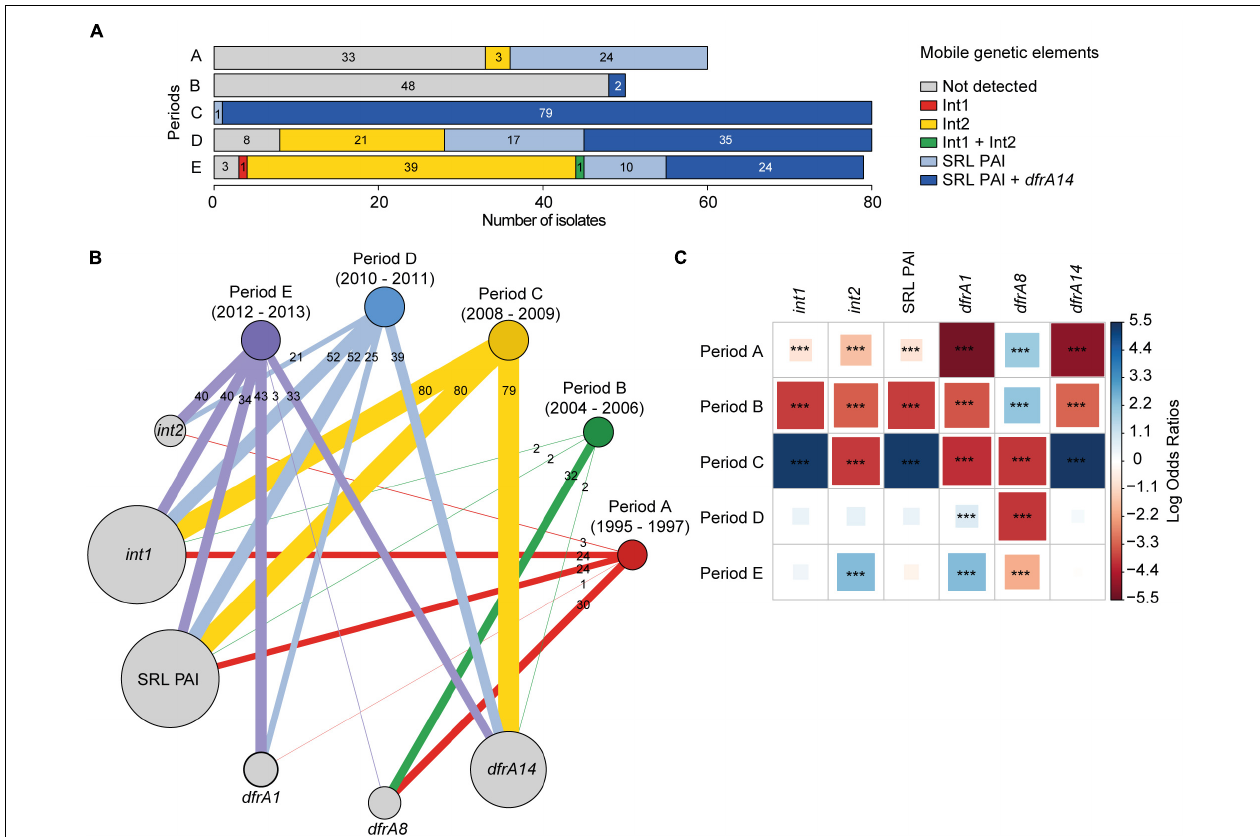
FIGURE 3 | Patterns of association between the Shigella sonnei isolation date (periods A–E) and genetic elements related to antimicrobial resistance. (A) Distribution of class 1, class 2 integrons, SRL PAI, and dfrA14 gene. (B) Graph of modules showing the interactions between periods of isolation and specific genetic determinants. Modules are weighted by the number of strains. Besides this, links are weighted by both the number of strains linked between modules and the number of strains within modules. The figure was prepared using the igraph (Csardi, 2015) package in R (R Core Team, 2014). (C) Pairwise association plot for periods of isolation and specific genetic elements. Red and blue squares represent negative and positive associations, respectively. The color scale represents the magnitude of the association determined by odds ratios. *** p < 0.001 determined by Pearson’s chi-square test or Fisher’s exact test. The figure was prepared using the package corrplot (Wei et al., 2017) in R (R Core Team,